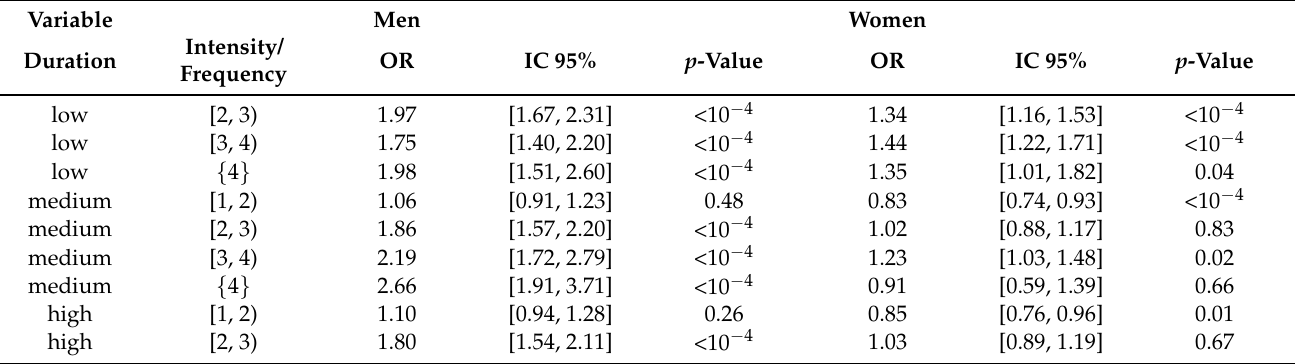
Table 5. Results of adjusted logistic regression of severe knee pain with kneeling, men and women